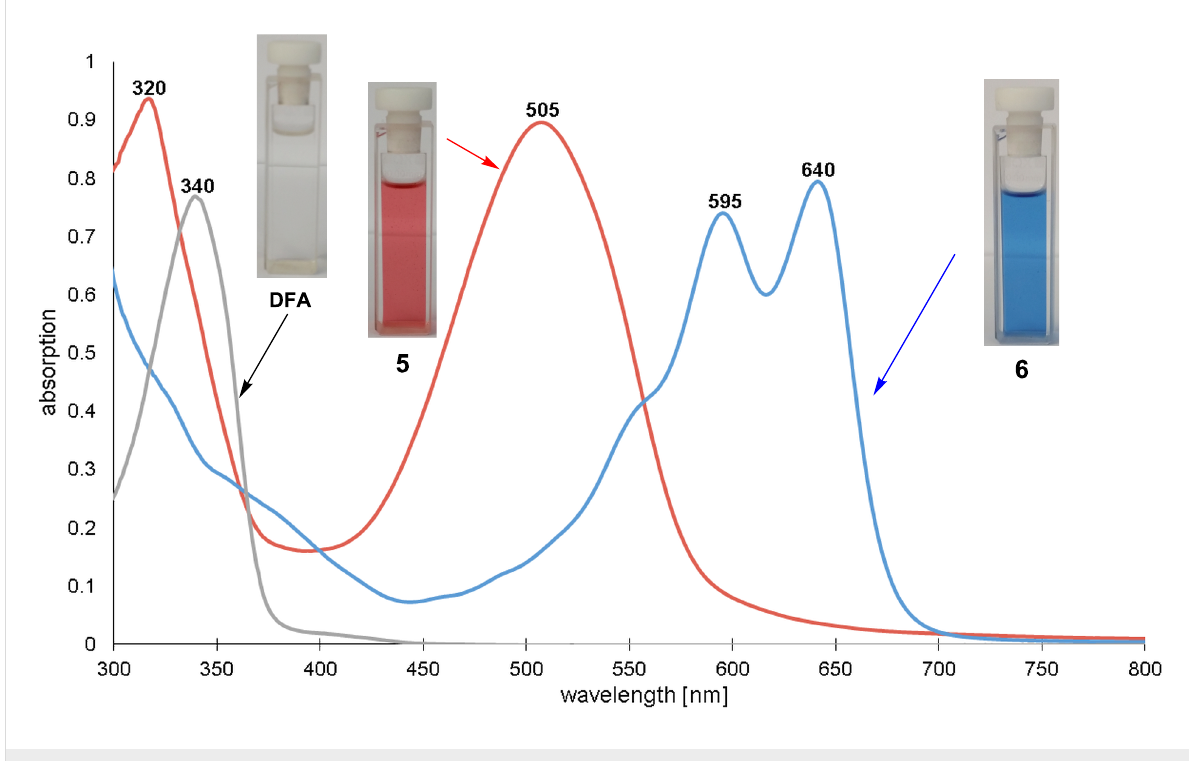
Figure 2: UV–vis spectra of oligomers 5 ( c = 0.16 g/mL, red), 6 ( c = 0.63 g/mL, blue) and DFA ( c = 0.016 g/mL,